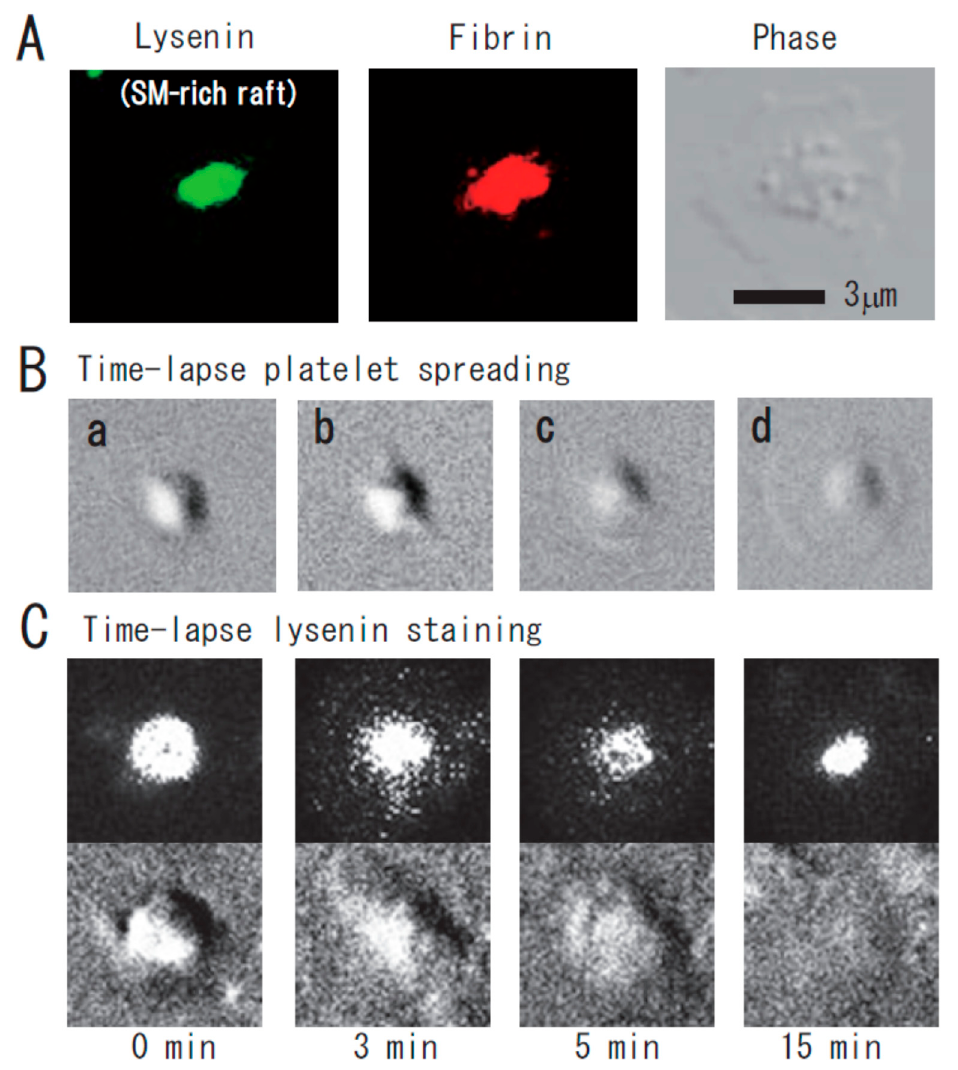
Figure 2. Immunocytochemical colocalization of fibrin with sphingomyelin-rich rafts in central region of spreading platelets stimulated with thrombin. ( A ) Immunocytochemical colocalization of fibrin with sphingomyelin-rich rafts in central region of thrombin-stimulated spreading platelets. Green fluorescent protein (GFP)–lysenin-positive sphingomyelin-rich rafts ( left panel ). Alexa 594-labeled fibrin ( middle panel ). Phase contrast ( right panel ). Scale bar, 3 µ m. ( B ) Time-lapse platelet spreading after thrombin stimulation on fibronectin-coated glass strip. ( a ) 0 min; ( b ) 0.2 min, filopodia formation; ( c ) 2 min, spreading; ( d ) 10 min, complete spreading. ( C ) Time-lapse lysenin-positive sphingomyelin-rich raft staining. Washed platelets were incubated with GFP-lysenin for 10 min and then stimulated with 1 U / mL thrombin. The time-lapse fluorescent and DIC images were captured using Olympus LCV110.